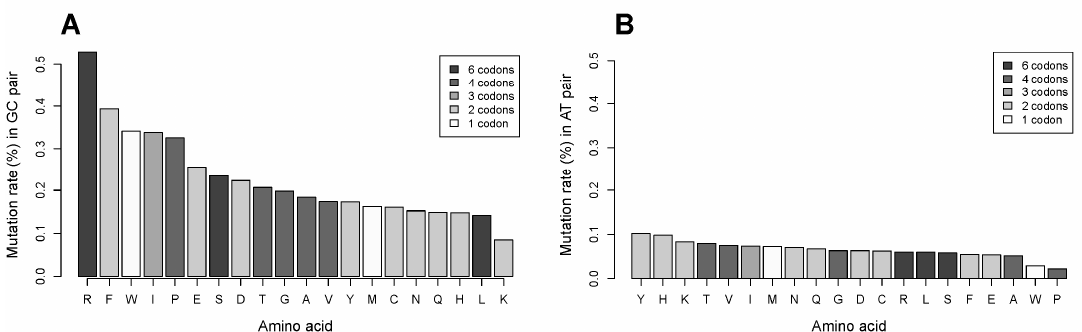
Figure 7. Mutation rates in the GC ( A ) and AT ( B ) pairs of nucleotides for each amino acid. The rates were calculated as ratios of single nucleotide substitutions in the GC and AT pairs (both coding and silent substitutions included) for each amino acid in the COSMIC database to the numbers of the GC and AT pairs coding for the amino acid in the analyzed subset of genes.